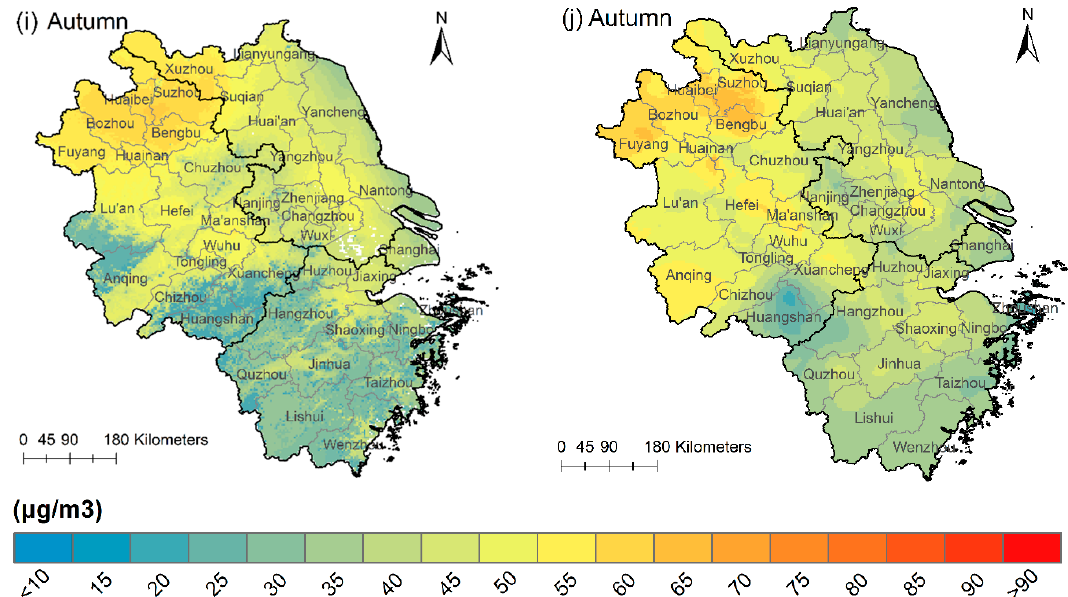
Figure 6. PM 2.5 spatial distribution obtained from ESFR models ( a , c , e , g , i ) and Kriging interpolation of ground observations ( b , d , f , h , j ).